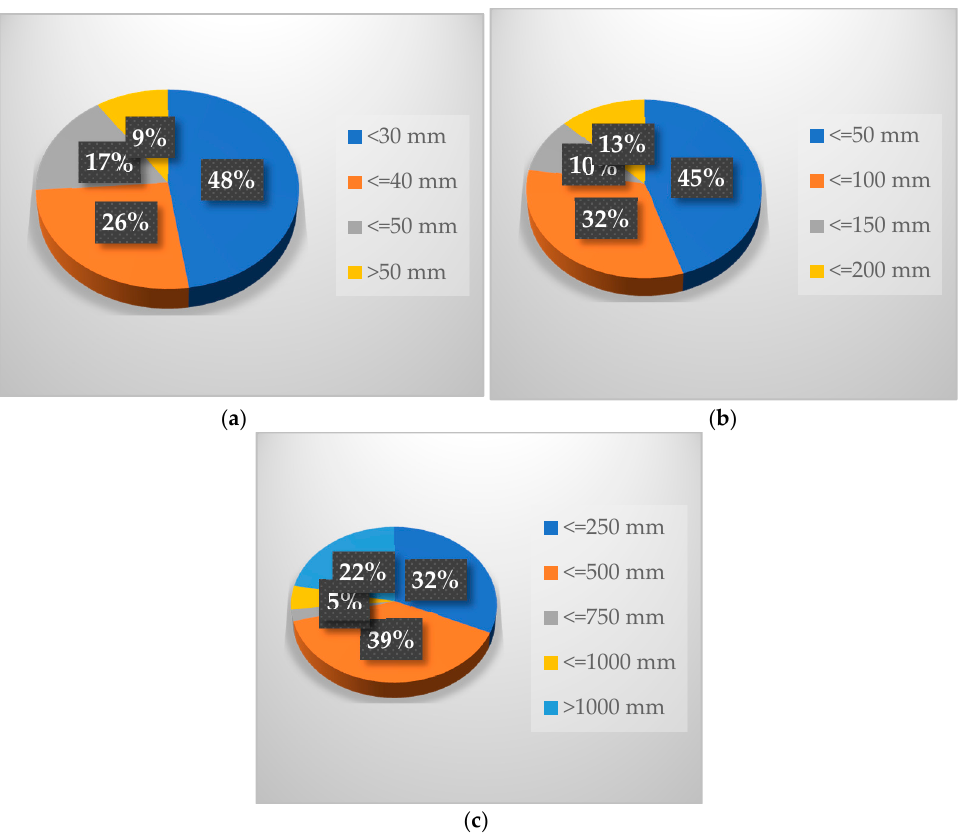
Figure 12. Dimensions of the used wood samples: ( a ) thickness, ( b ) width, and ( c ) length.